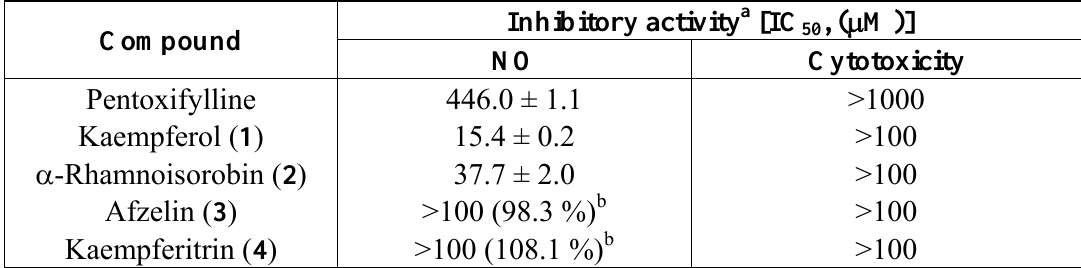
Table 2. NO inhibitory activity of kaempferol and its